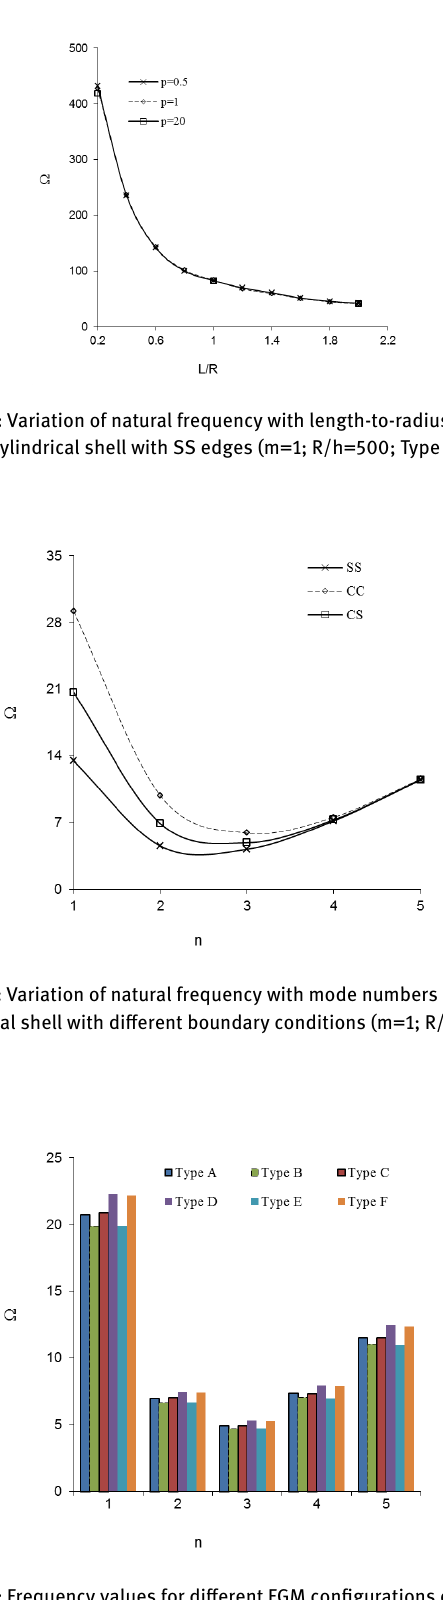
Figure 4: Frequency values for different FGM configurations of C-S